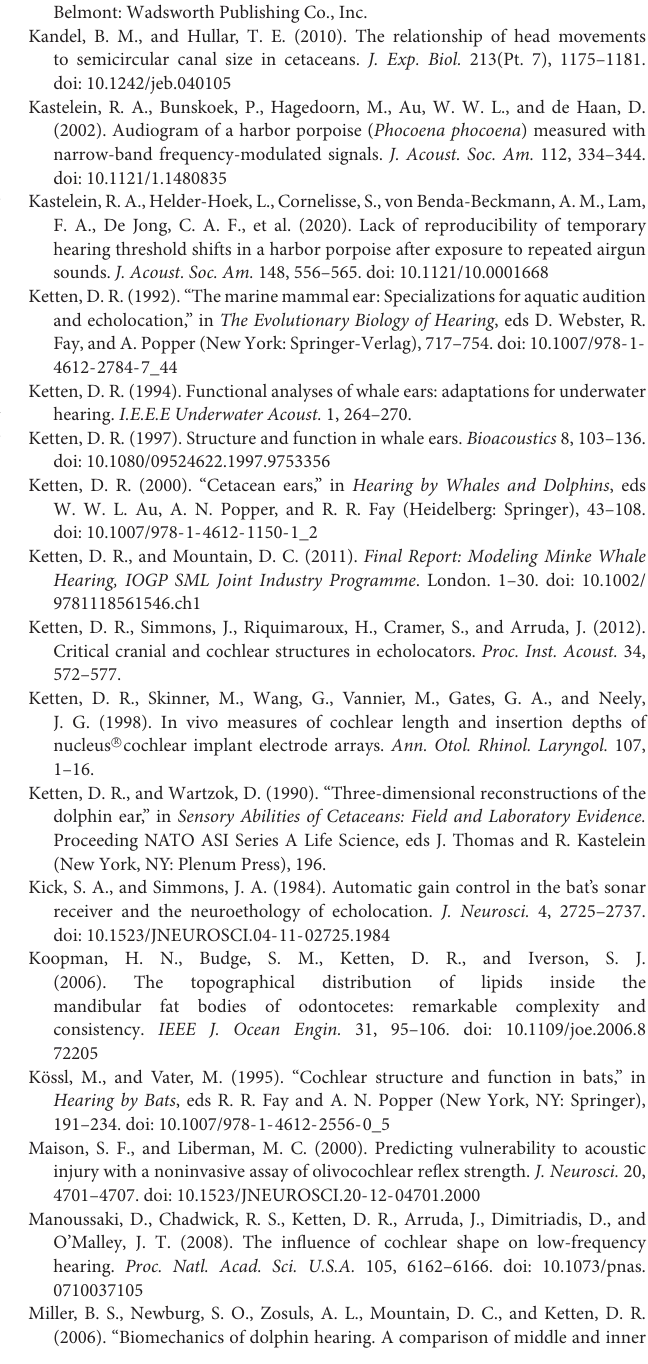
to show the 2.25 turn spiral of the cochlea (see Figure 1 for labeling of structures. Images and multimedia copyright© 2021 DK, all rights reserved). Supplementary Video 2 | The data for the video were obtained from images produced in Amira from VG Studio Max 3.4 images reconstructions of 7–11 micron voxel acquisitions of microCT data obtained with an X-Tek MicroCT. The video shows the inner ear anatomy of a male bat ( Eptesicus fuscus ) first as the full periotic capsule (red) with the stapes (white), incus (white), and malleus in place.